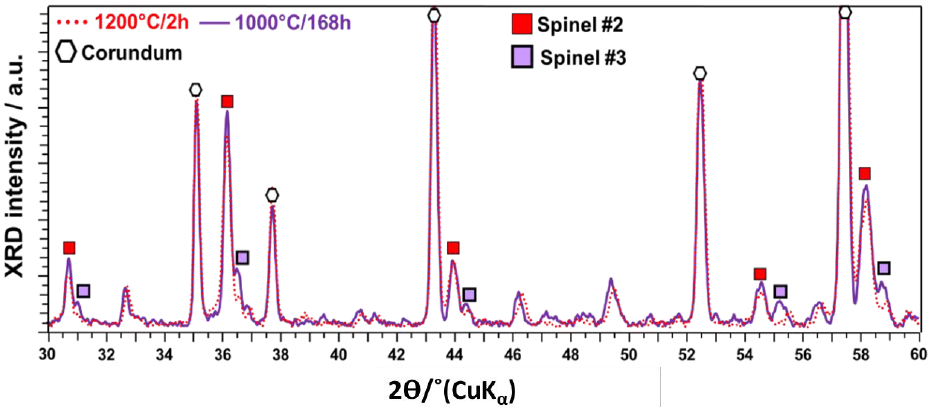
Figure 7. XRD profiles taken from the surface of spinel-coated bauxite proppants reveal the presence of two spinel phases (#2, #3). After thermal aging (168 h/1000 ◦ C), the peak intensities of spinel #3 of two spinel phases (#2, #3). After thermal aging (168 h/1000 °C), the peak intensities of spinel #3 with smaller lattice parameters have increased with smaller lattice parameters have increased significantly. Table 1. Chemical composition of spinel-type pigment in as-received condition, after coating pro- cess and thermal aging.